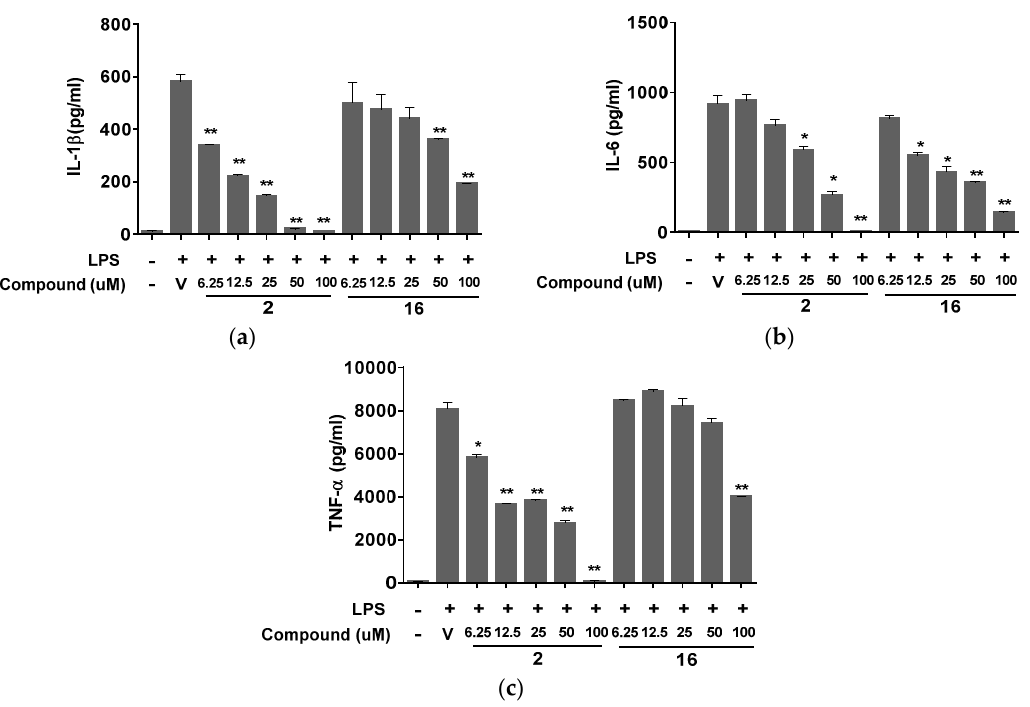
Figure 4. Effects of compound 2 and compound 16 on soluble mediators of inflammatory response. Raw 264.7 cells were stimulated with 1 μ g/mL LPS and co-treated with various concentrations of compound 2 , compound 16 or vehicle (0.1% DMSO in PBS) as a control. After 24 h, the concentrations of IL-1 β ( a ); IL-6 ( b ); and TNF- α ( c ) rerelease in the culture supernatants were determined using ELISA kit for each mediator. Data are means ± SD of one duplicated representative experiment. Differences between each treatment group against LPS control group were analyzed and statistical significances are denoted as * p < 0.05 or ** p < 0.01. LPS, lipopolysaccharide; DMSO, dimethyl sulfoxide; PBS, phosphate-buffered saline; SD, standard deviation.